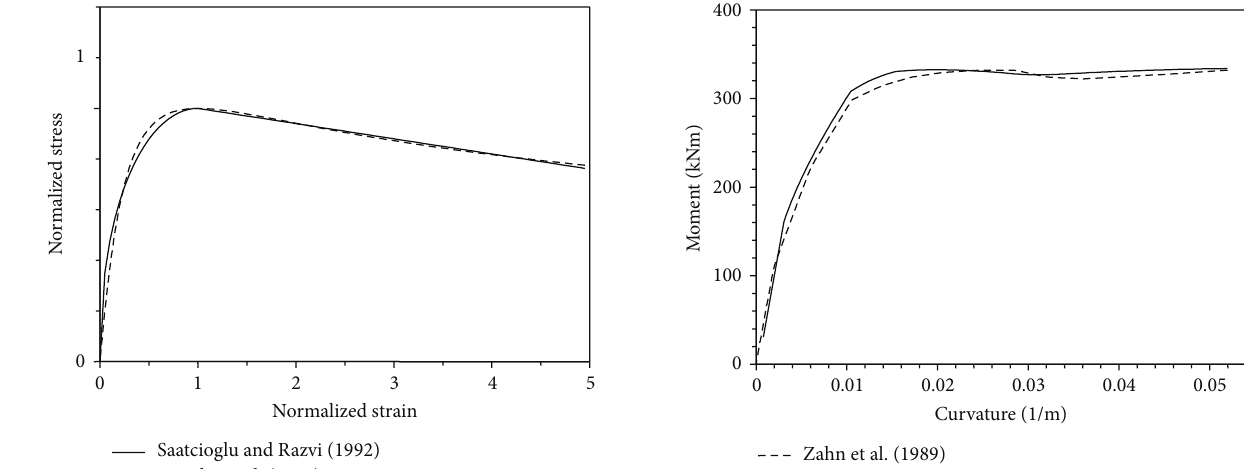
strength 𝑓 co = 30 N/mm 2 . The longitudinal reinforcement consisted of 12 steel bars of diameter 16 mm, having yielding strength 𝑓 𝑠𝑦 = 420 N/mm 2 , uniformly distributed along the perimeter of the concrete core (constant pitch). The cover depth, measured from the external perimeter of the stirrups, was 13 mm. The transverse reinforcement, consisting of steel stirrups of diameter equal to 10 mm, according to the calcu- lations made by the aforementioned authors, provided the effective confinement pressure 𝑓 ℓ𝑒 = 0.11𝑓 0.85𝑓 co is the reduced strength value prescribed by the ACI 318 code [28].